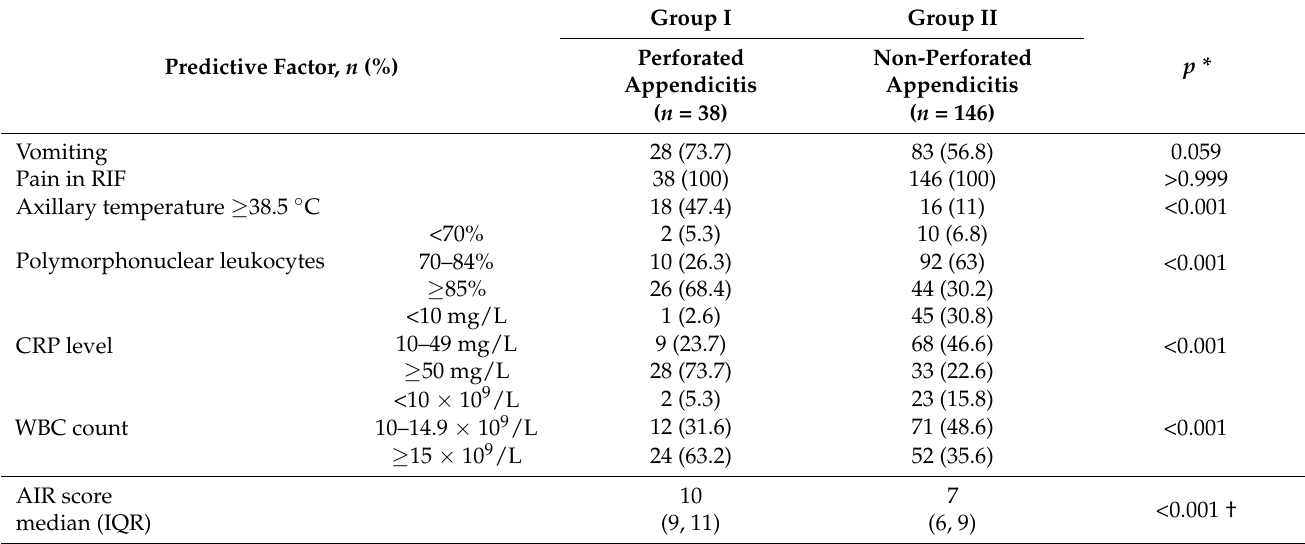
Table 4. Predictive factors analysis of the AIR score.